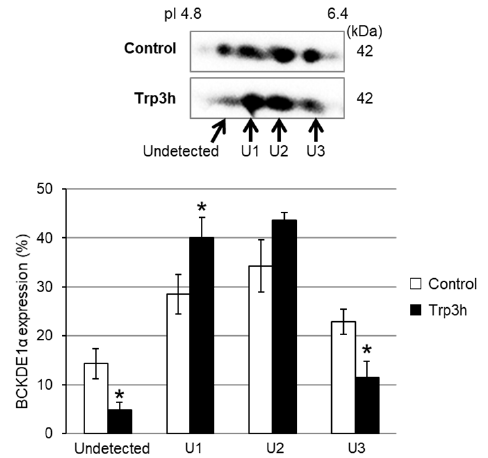
Figure 3. Altered expression of BCKDE1 α in the liver after oral administration of Trp. Liver lysates were immunoblotted for BCKDE1 α . The bar graph shows the expression of each BCKDE1 α protein spot as a percentage of total BCKDE1 α expression (Undetected + U1 + U2 + U3). Data are expressed as means ± SEM, n = 5. The protein spot designated “Undetected” could not be detected in CBB-stained gels. (*) Indicates significant difference between control versus Trp 3 h ( p < 0.05).